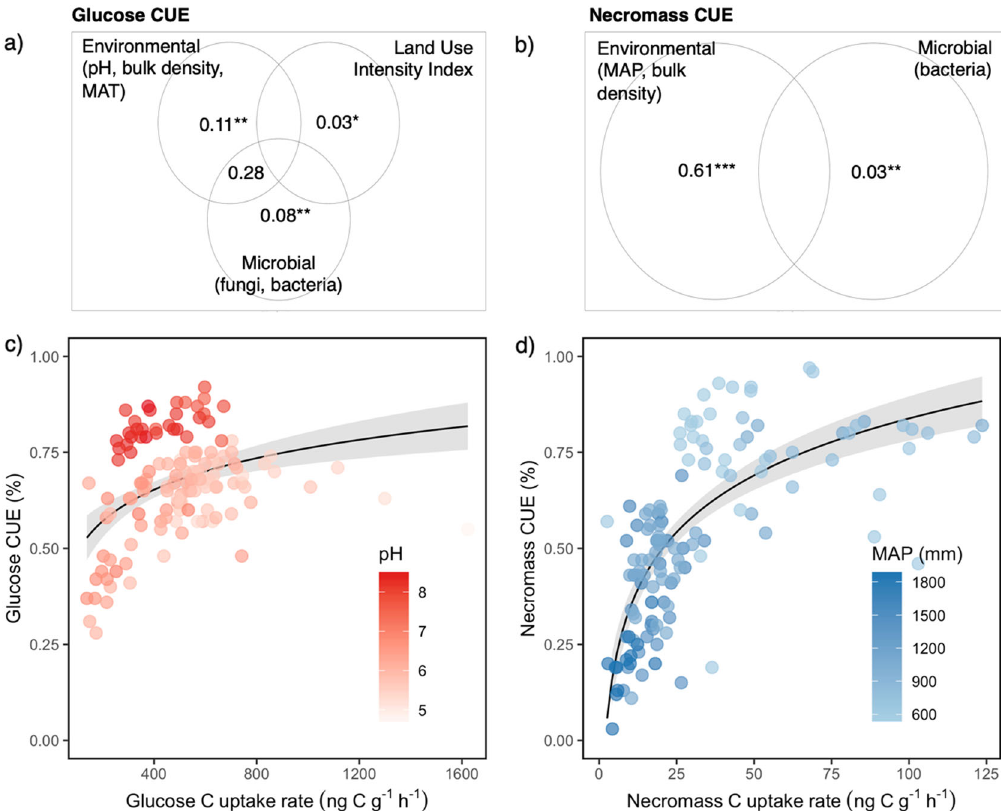
Fig. 4 Environmental and microbial controls on glucose and necromass carbon use ef fi ciency. Partitioning of the unique and shared variance between the main environmental and microbial controls on CUE-glucose ( a ) and CUE-necromass ( b ). Only signi fi cant partitions are shown ( P < 0.05). Log-relationship between CUE and C uptake rate (proxy for growth rate) for glucose ( c ) and necromass ( d ). Curves are the logarithmic regression and the shaded area is the 95% con fi dence interval for the CUE~growth rate relationship (Glucose: R 2 adj = 0.16, P < 0.001; Necromass: R 2 adj = 0.53, P < 0.001), colored by pH & MAP to show relationship between dominant environmental controls on CUE and growth rate (Glucose~pH: R 2 adj = 0.14, P < 0.001: Necromass~MAP: R 2 = 0.45, P < 0.001) ( n = adj